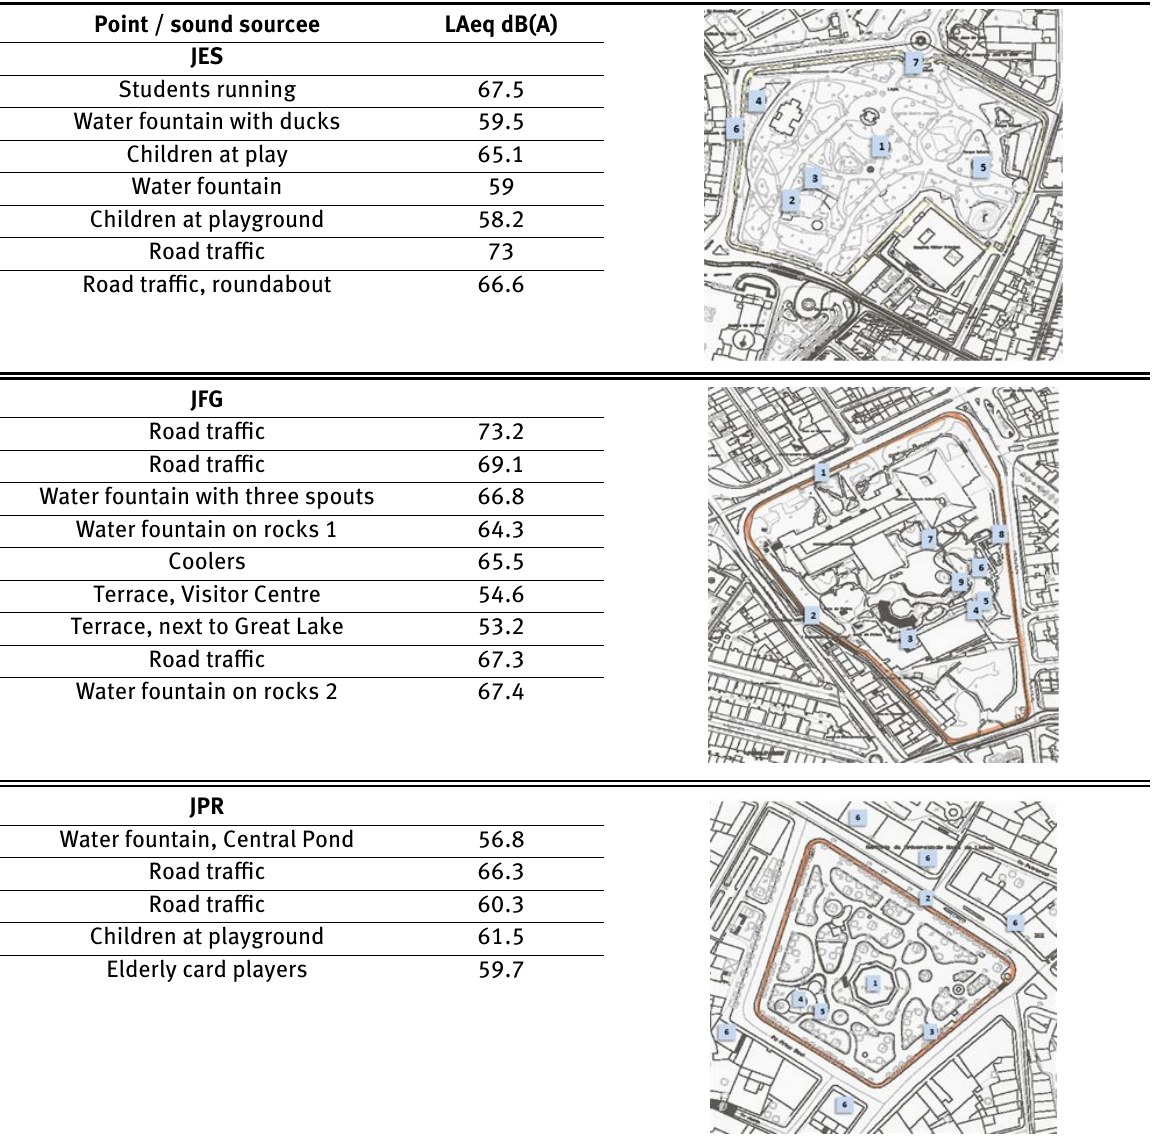
Table 2: Point / Sound sources in Lisbon